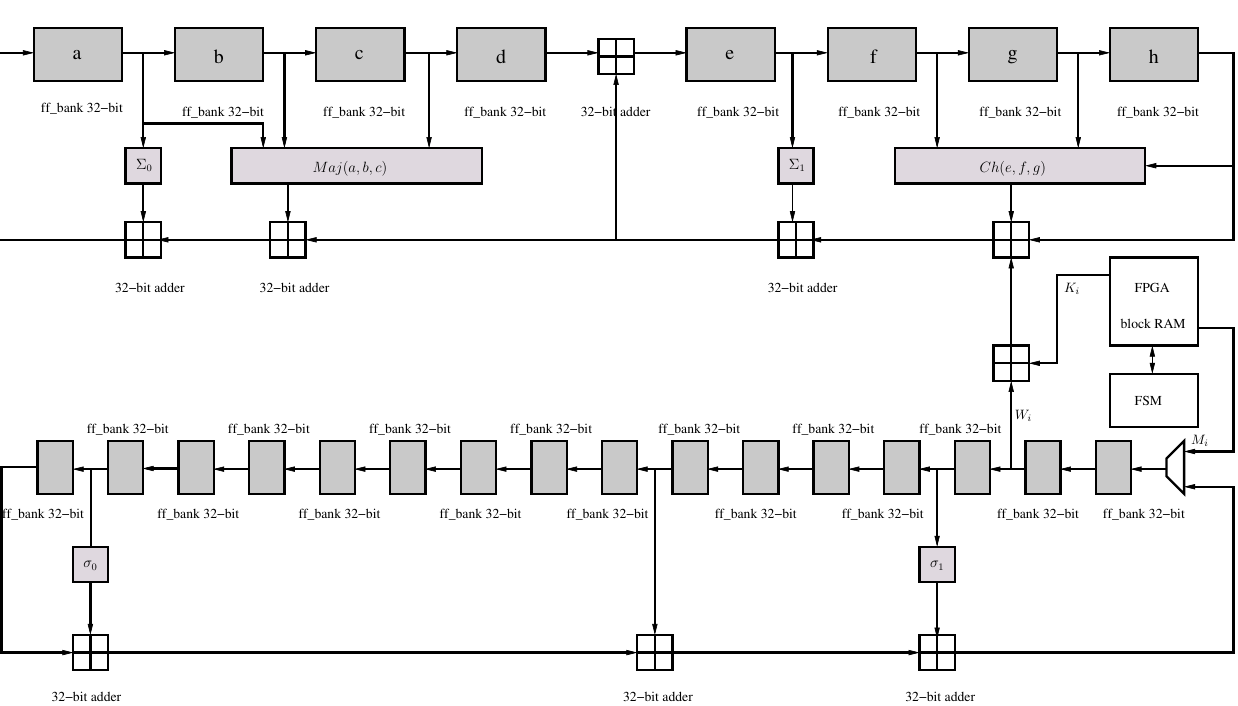
Figure 6. Organization of the secure hash algorithm (SHA)-256